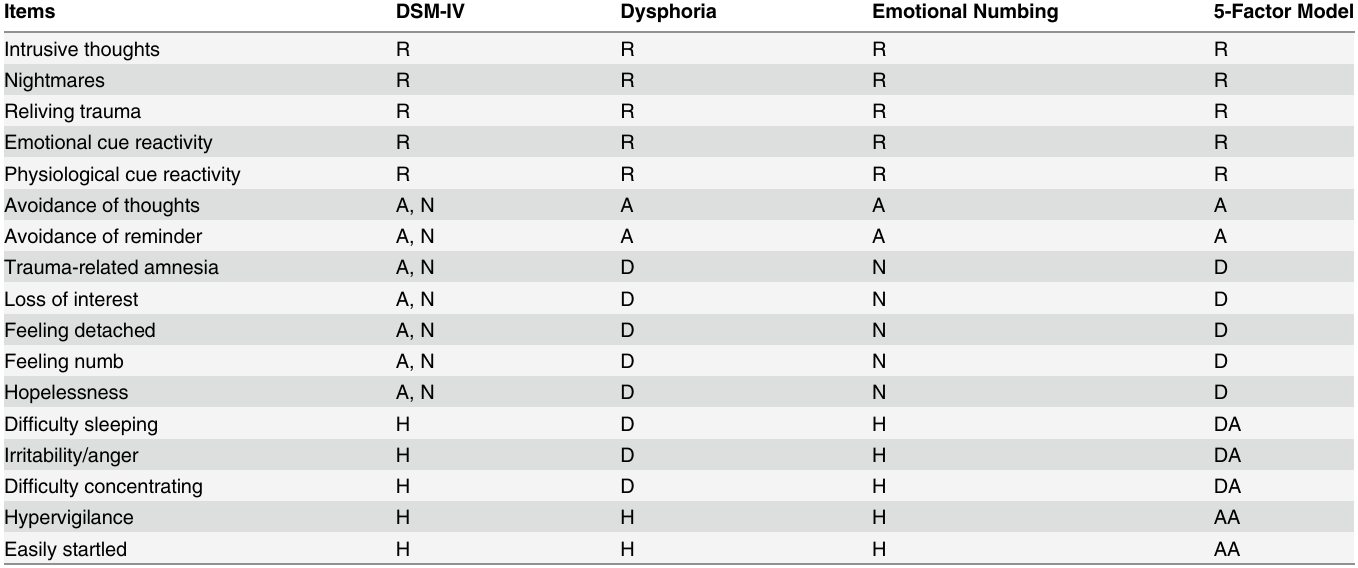
Table 1. Item Mapping for PTSD